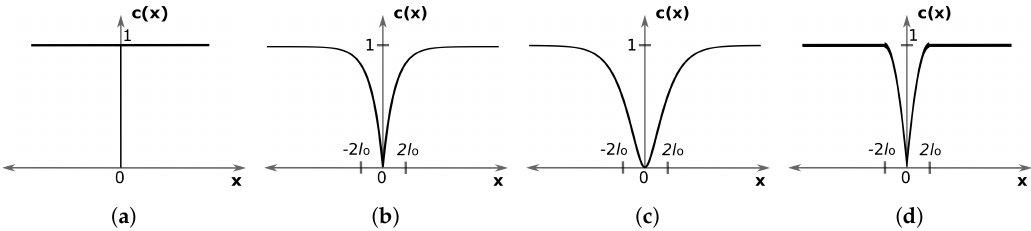
Figure 7. 1-D spatial variation of phase-field c ( x ) for ( a ) Discrete crack ( b ) Diffused crack with second-order quadratic approximation ( c ) Diffused crack with fourth-order quadratic approximation, and ( d ) Diffused crack with second-order linear approximation.